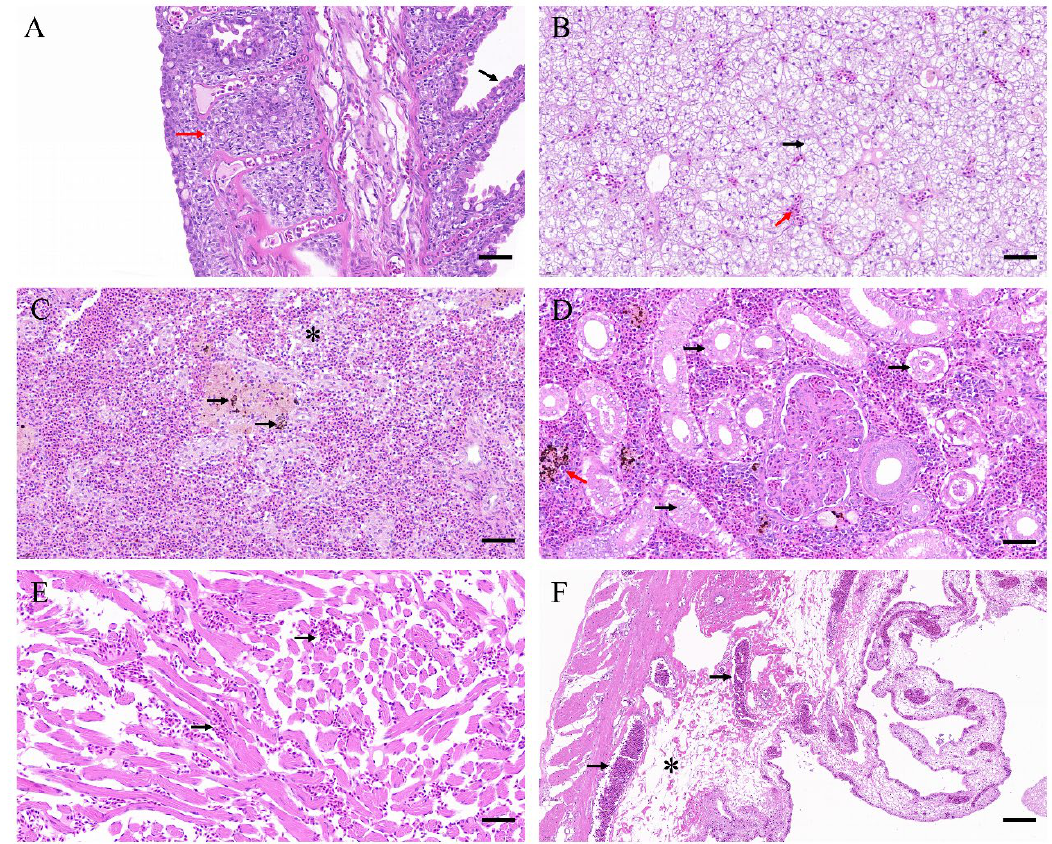
Figure 2. Histopathology of CSBV Bces-Po19 infected Japanese flounder ( Paralichthys olivaceus ). ( A ) Gill, with black arrow indicating the gill lamella with slight hyperplasia; red arrow indicates the gill lamella in stick shape with obvious hyperplasia. ( B ) Liver, with black arrow indicating the vesicular degeneration of hepatocytes; red arrow indicates sinus dilatation and blood cells extravasation. ( C ) Spleen, with black arrows indicating the hemolytic plaque; asterisk indicates vacuolated spleno- cytes. ( D ) Kidney, with black arrows indicating tubular epithelial cells necrosis; red arrow indicates renal stroma hemolysis. ( E ) Heart, with black arrows indicating the congestive tissue with erythro- cytes. ( F ) Stomach, with black arrows indicating infiltrated hemocytes in the submucosa; asterisk indicates necrotic loose connective tissue of submucosa. Scale bars: 40 μm.